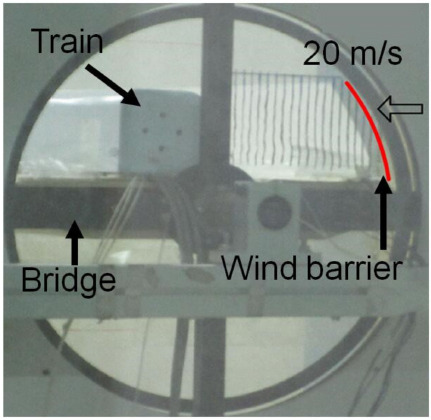
Figure 5. Deformed shapes of the wind barrier at an airflow speed of 20 m / s.